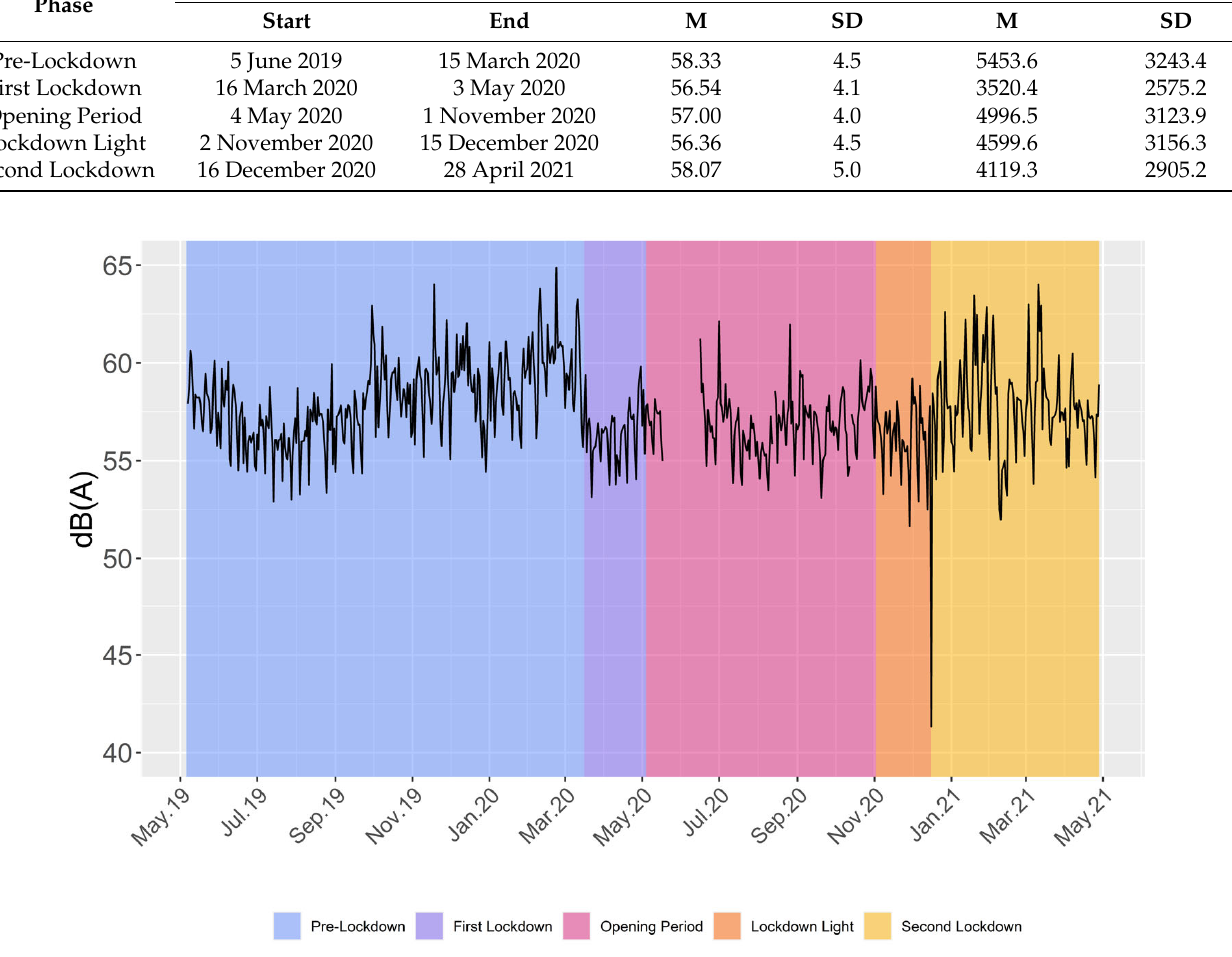
Figure 1. Mean daily dB(A) levels over the study period. Fluctuations arise from differences between days. The missing data between May and June 2020 is due to maintenance of the recording